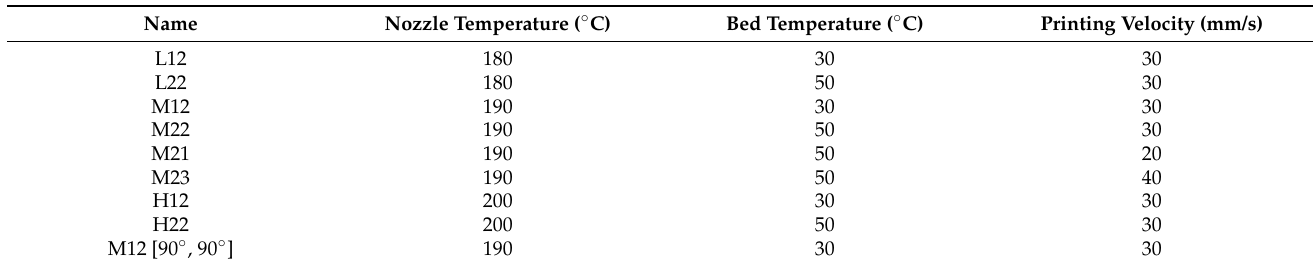
Table 2. Printing conditions explored in this